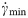
Influence of the change of vessel volume ΔVtot on (a) the Minimum shear rate γ˙min over the cardiac cycle, (b) Peak Wall Rupture Index PWRI at Mean Arterial Pressure (MAP). Influence of the Intra-Luminal Thrombus (ILT) volume growth rate ΔVILT on (c) maximum thickness of the ILT layer HILT max, and (d) PWRI at MAP.